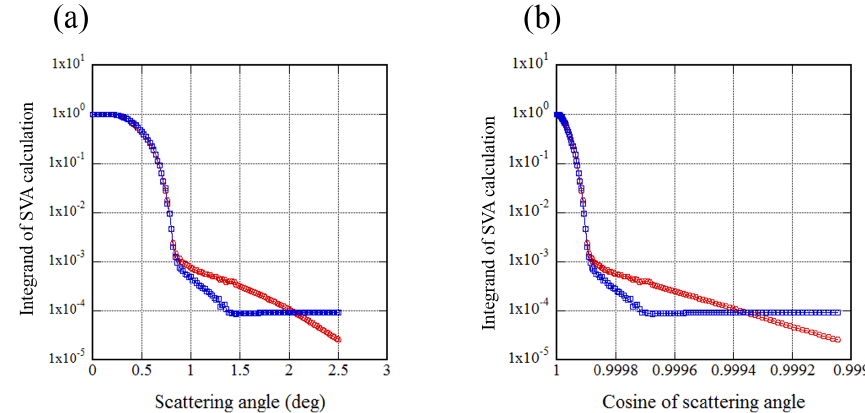
Figure 4. Example of the integrand of the SVA calculation. The blue line with open squares is for the case that the minimum value is subtracted, and the red line is for the case that the values between 1.4 and 2.5 ◦ are extrapolated using the data from 1.0 to 1.4 ◦ . Table 1. Settings of the SVA calculation. Subtract minimum Consideration of Extrapolation FOV value airmass change method shape Case 1 yes no current elliptic current elliptic elliptic current circular